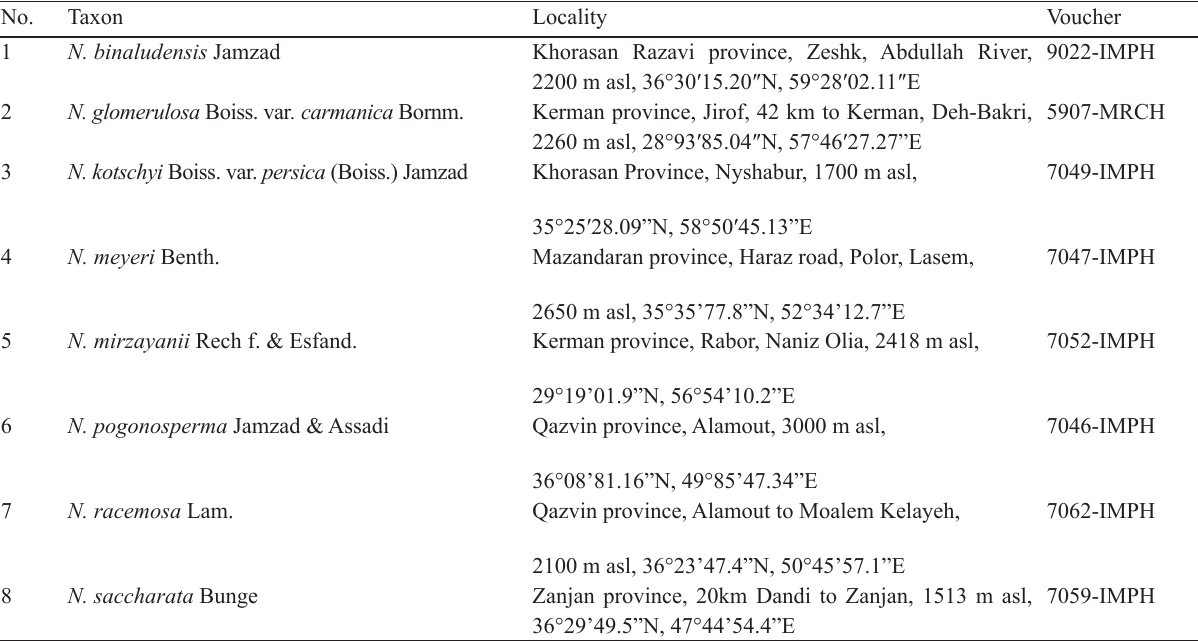
Table 1. General information on the eight populations of Nepeta collected in